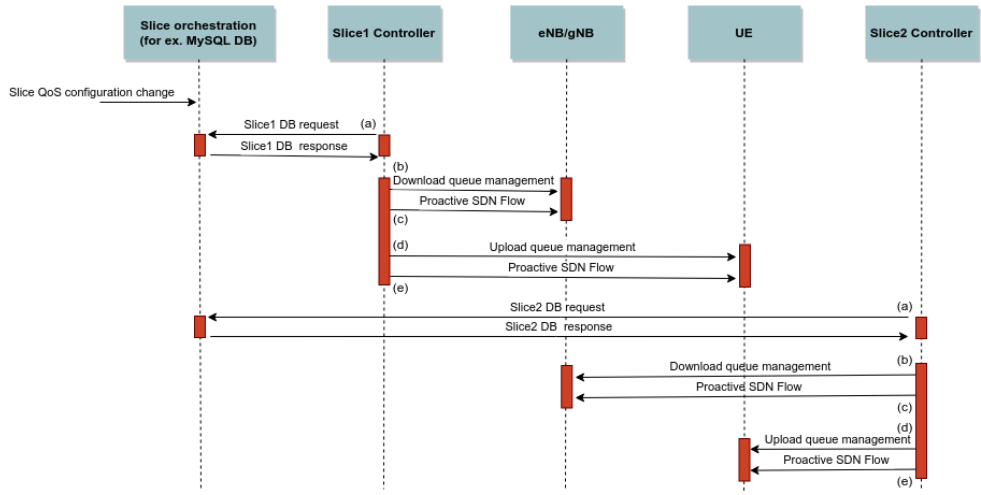
Figure 3. QoS policy change flow